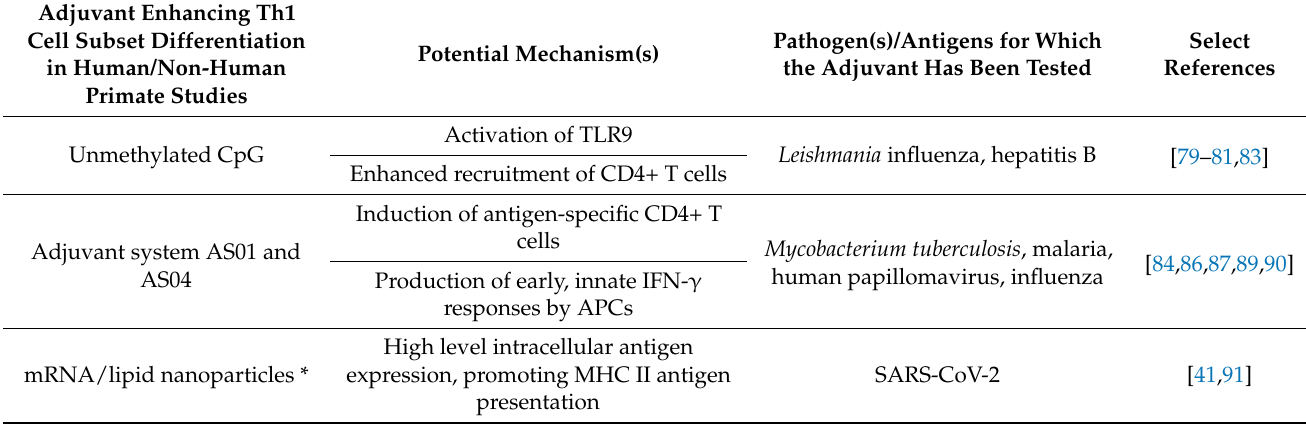
Table 3. Adjuvants enhancing Th1 cell subset differentiation in human/non-human primate